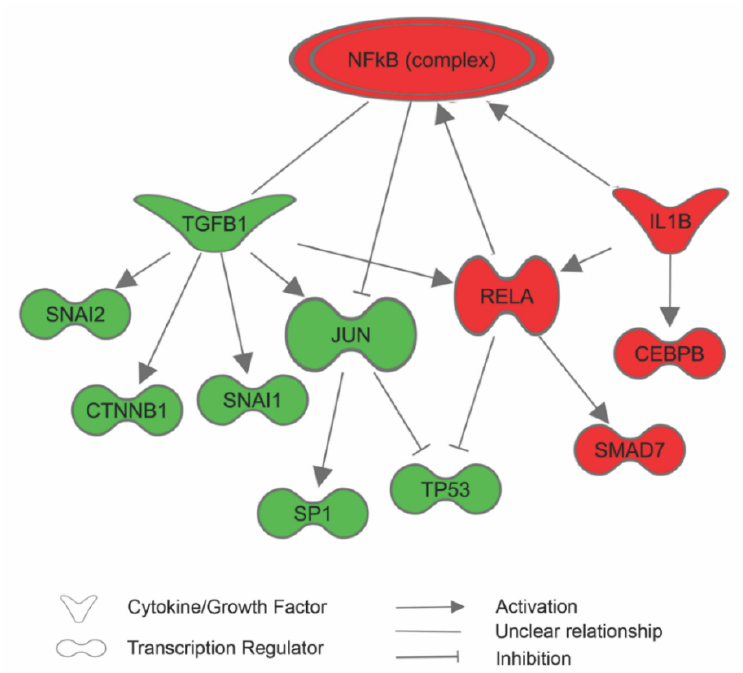
Figure 4. Based on the differentially expressed proteins, Ingenuity Pathway Analysis (IPA) predicted that the NF- κ B pathway was activated in human fetal retinal pigment epithelial cells (RPE) cultured in Dulbecco’s Modified Eagle’s Medium (DMEM) with 1% sericin. The prediction was based on upregulation (red symbols) of several of its promoters and the concurrent downregulation (green symbols) of regulators that are known to be inhibited by the NF- κ B pathway. For the sake of clarity, some extraneous relationships have been omitted, but are included in the Supplementary Material.